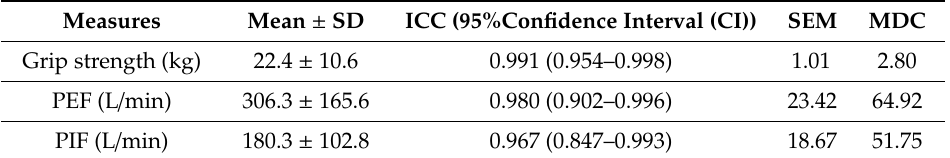
Table 2. Intra-rater reliability of grip strength, peak expiratory flow (PEF) and PIF.